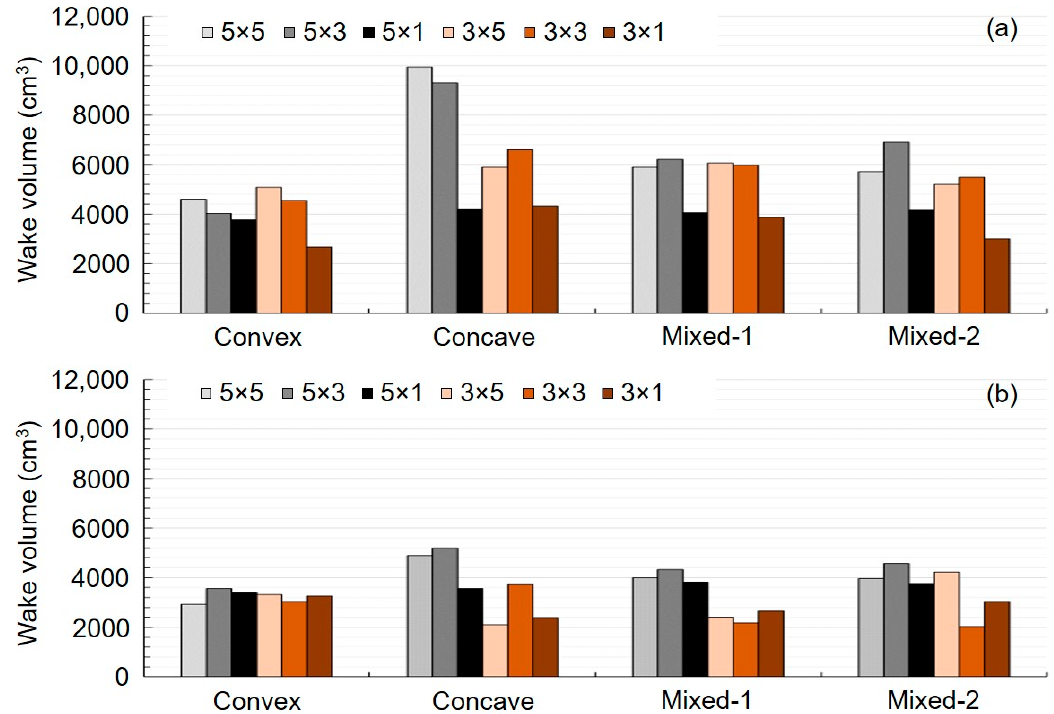
Figure 7. Wake volumes of the initial AOR models: ( a ) shell penetration depth of 10%; ( b ) shell penetration depth of 50%.